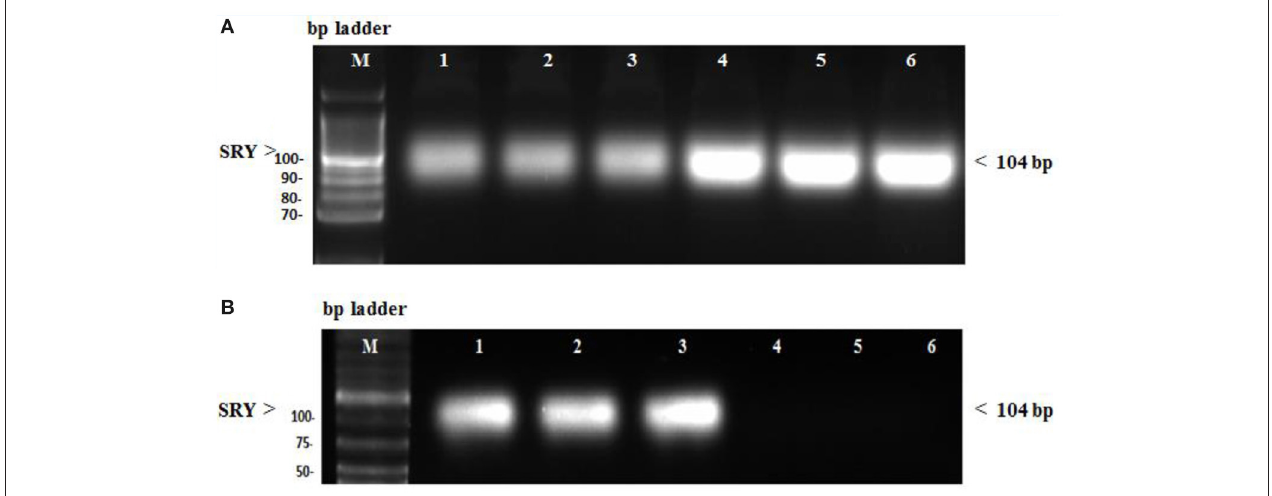
FIGURE 7 | (A) SRY gene expression in female kidney tissue rats evaluated by conventional PCR. Lane M: DNA molecular mass marker. Lane 1–3: sample injected with only stem cells (second group). Lane 4–6: sample treated with stem cells before being injected with GM (preventive fourth group). (B) SRY gene expression in female kidney tissue rats evaluated by conventional PCR. Lane 1–3: sample injected with GM, then treated with stem cells (treated fifth group). Lane 4–6: sample did not receive any treatment (normal control first